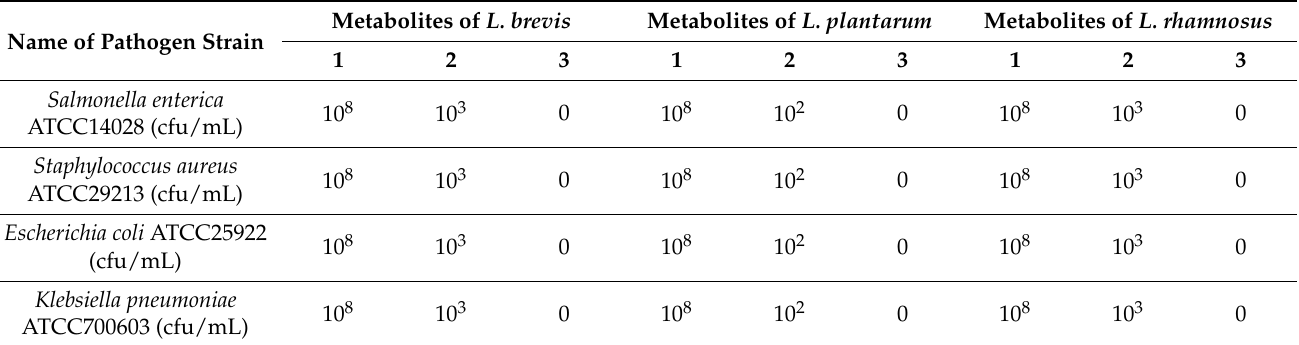
Table 4. The inhibition of pathogens’ growth by active antimicrobial substances produced by Levilac- tobacillus brevis , Lactiplantibacillus plantarum and Lacticaseibacillus rhamnosus .